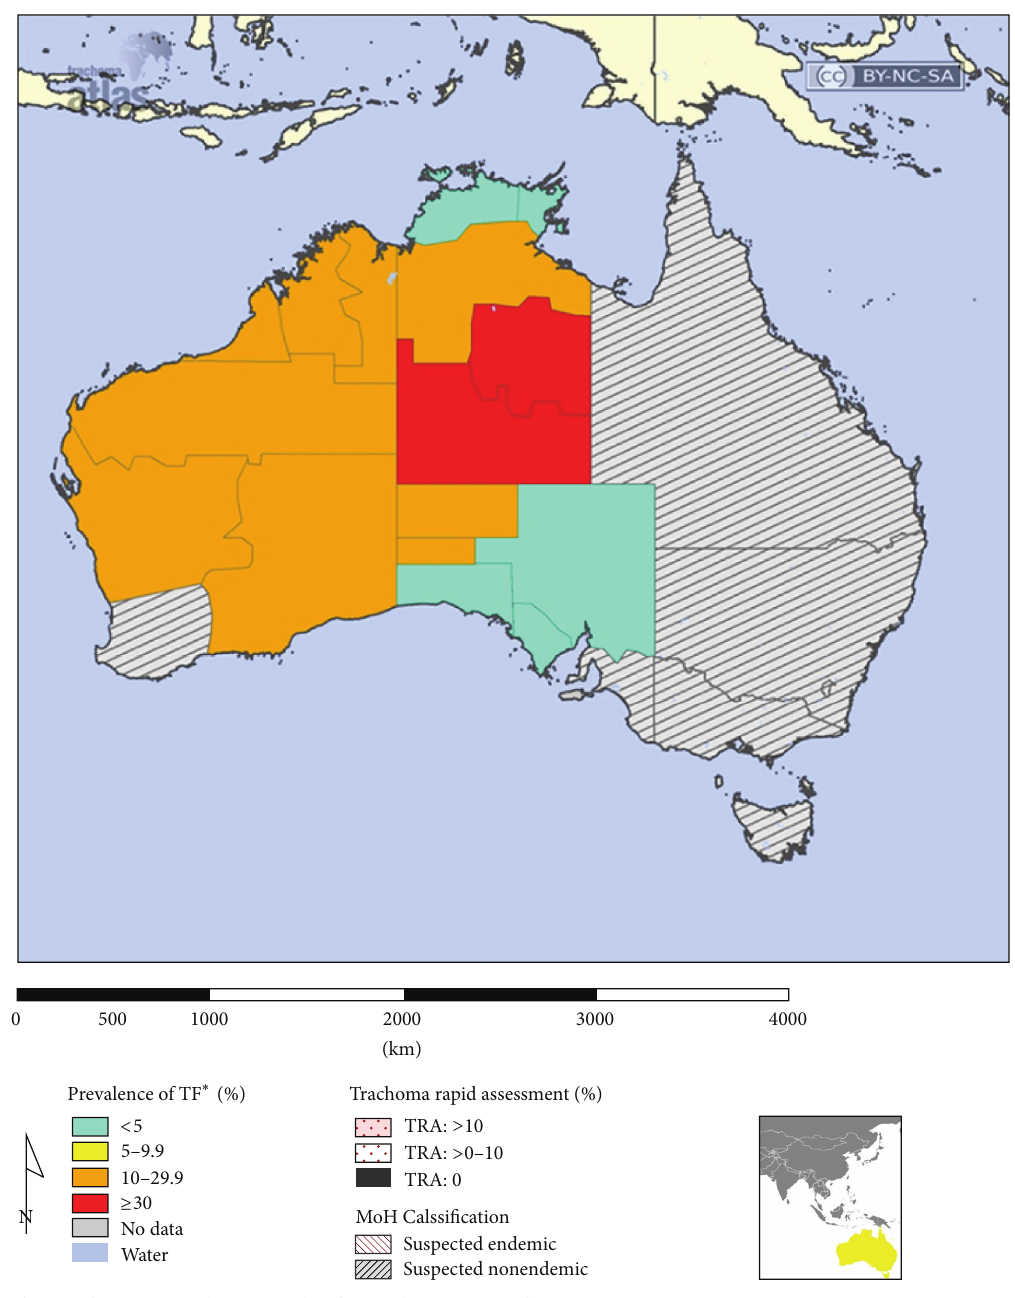
Figure 2: Active trachoma screening in indigenous Australian, Aboriginal, and Torres Strait Islander Communities in 2009 using trachoma follicular as clinical indicator. Figure courtesy of Trachoma Atlas